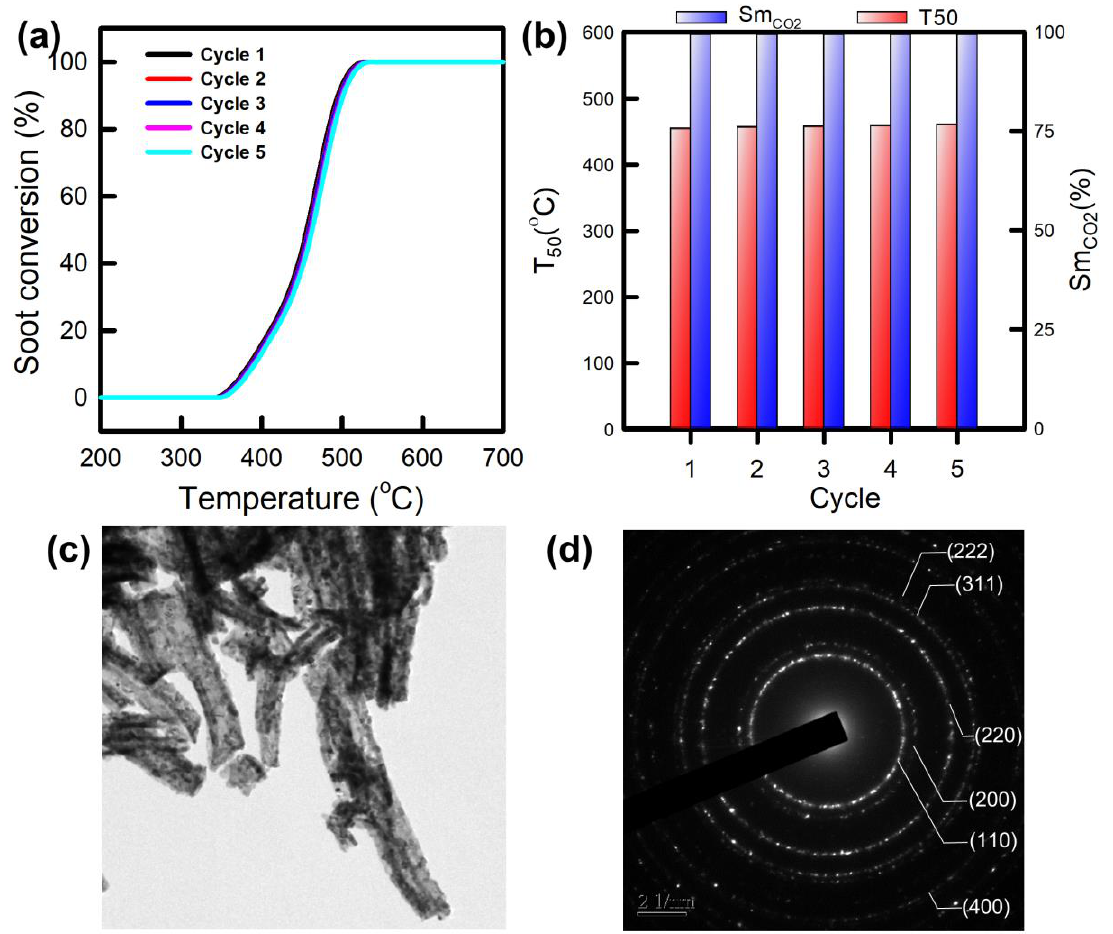
Figure 12. Recyclability of CeONB for multi-cycle soot oxidation: ( a ) soot conversion (%), ( b ) T m and S mCO2 , and ( c ) XRD pattern of used CeONB; ( d ) SAED pattern of used